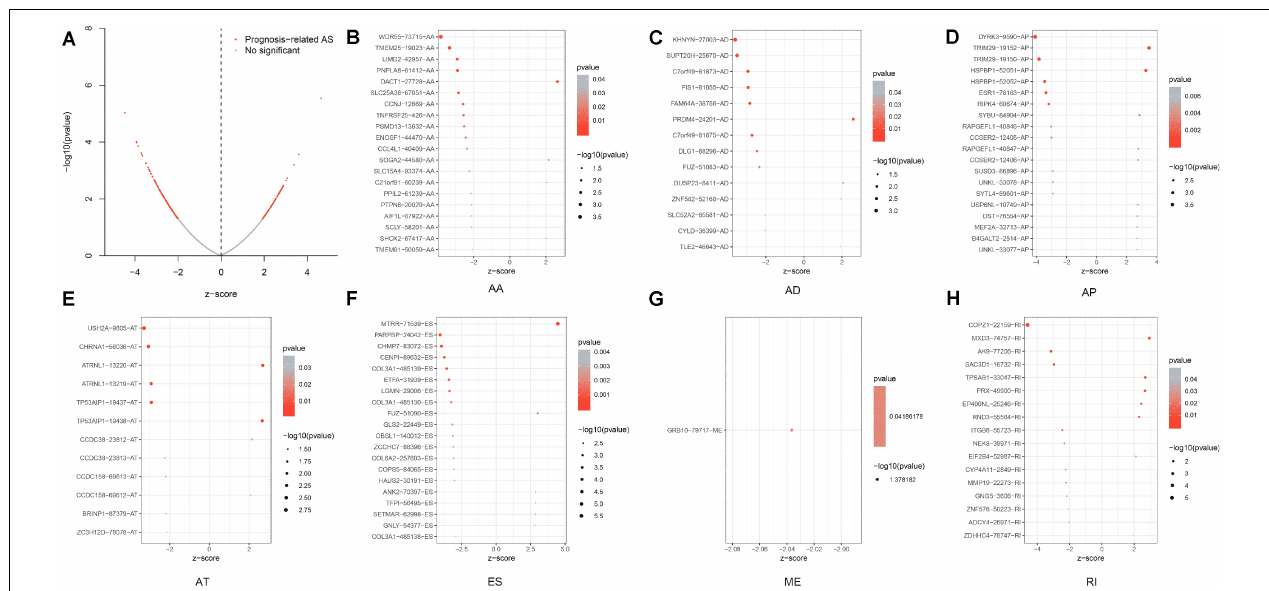
FIGURE 3 | Discovery of prognosis-related ASEs and OS-SEs. (A) The volcano plot of the boundary between significant prognosis-related (red dots) and insignificant prognosis-related alternative splicing events (blue dots). (B–H) The Bubble plots of overall-survival-associated splicing events in each type of splicing patterns. AA, alternate acceptor; AD, alternate donor; AP, alternate promoter; AT, alternate terminator; ES, exon skip; ME, mutually exclusive exons; RI, retained